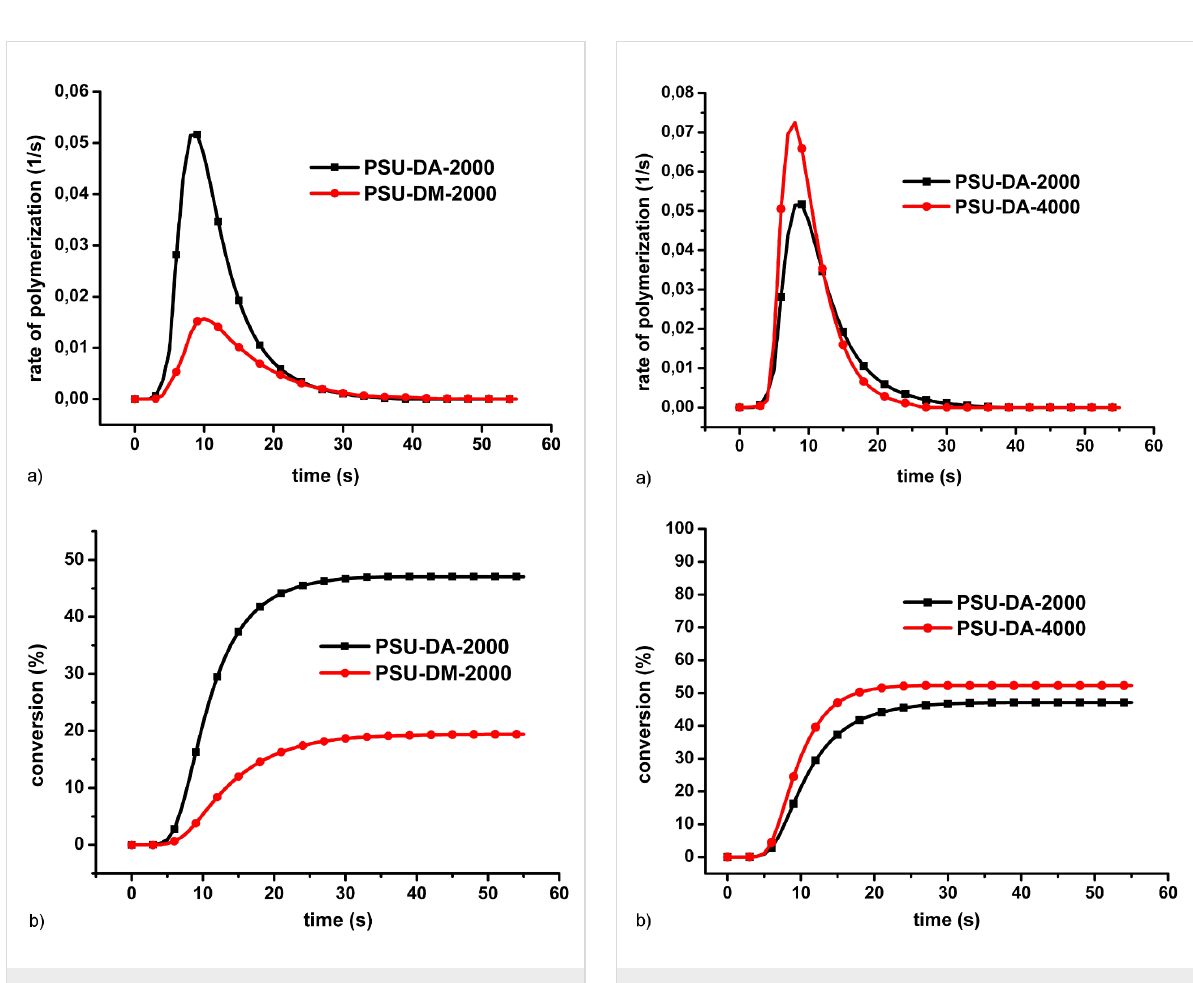
Figure 4: Rate (a) and conversion (b) of photo induced polymerization of PSU-DAs with different molecular